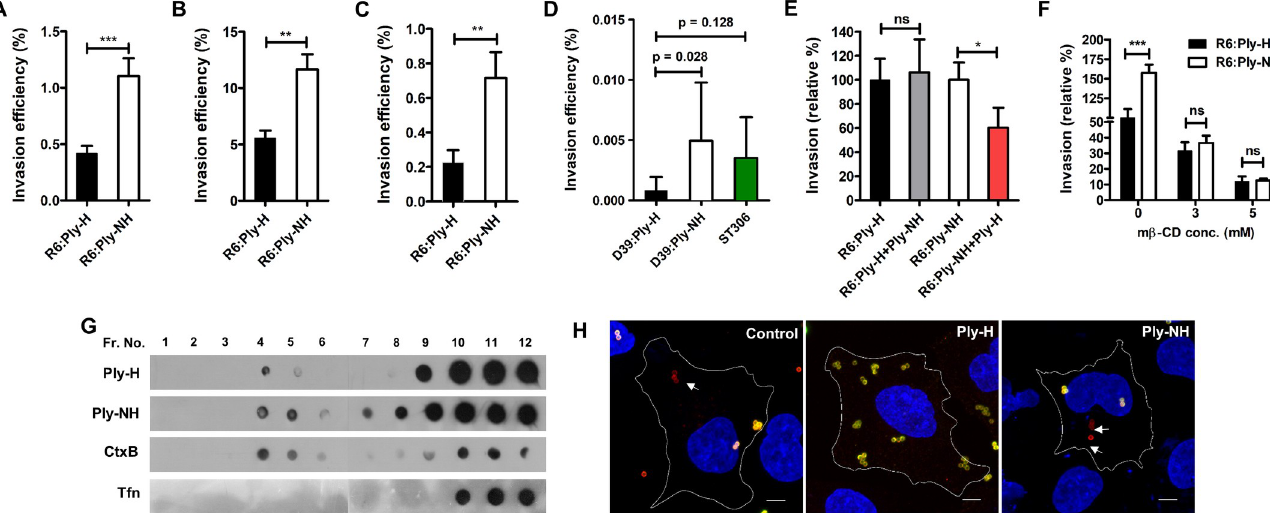
Fig 4. Abrogation of pore forming ability confers improved internalization capability in SPN strains harbouring Ply-NH. ( A-B ) Invasion efficiency of R6:Ply- H and R6:Ply-NH strains in A549 cells ( A ) and THP-1 cells ( B ). ( C-D ) Invasion efficiency of R6:Ply-H, R6:Ply-NH ( C ) and D39:Ply-H, D39:Ply-NH and ST306 strains ( D ) in primary human pulmonary alveolar epithelial cells. ( E ) Comparison of invasion efficiency of R6:Ply-H and R6:Ply-NH following pre-treatment of A549 cells with purified recombinant Ply-NH and Ply-H (0.1 μ g/ml), respectively. ( F ) Inhibition of internalization of R6:Ply-NH following pre-treatment of A549 cells with methyl β -cyclodextrin (M β -CD, 3 and 5 mM). ( G ) Dot blot showing localization of Ply-H and Ply-NH in low density lipid raft fractions of A549 cell membrane. CtxB and transferrin (Tfn) was used as positive and negative control, respectively. ( H ) Immunofluorescence image showing uptake of CtxB-FITC coated latex beads (1.1 μ m) by A549 cells following pre-treatment with Ply-H and Ply-NH. Internalized beads are shown in red (arrow mark) while external beads are dual (yellow) colored. Scale bar: 5 μ m. Data information: Experiments are performed thrice and data of representative experiments are presented as mean ± SD of triplicate wells. Statistical analysis was performed using Student’s two-tailed unpaired t-test (A-C; E-F) and one-way ANOVA with Tukey’s multiple comparison test (D). ns, non-significant; � p < 0.05; �� p < 0.01; ��� p < 0.001.